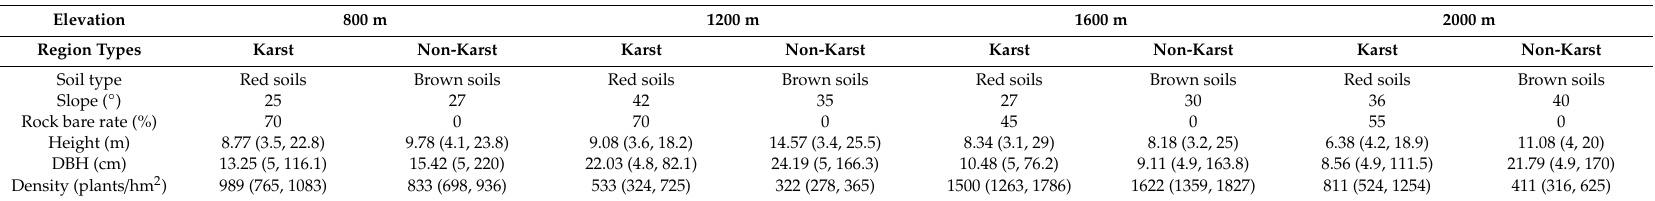
Table 1. Basic vegetation and soil characteristics of the established plots in the Dawei Mountain area in Yunnan Province, Southwestern China.